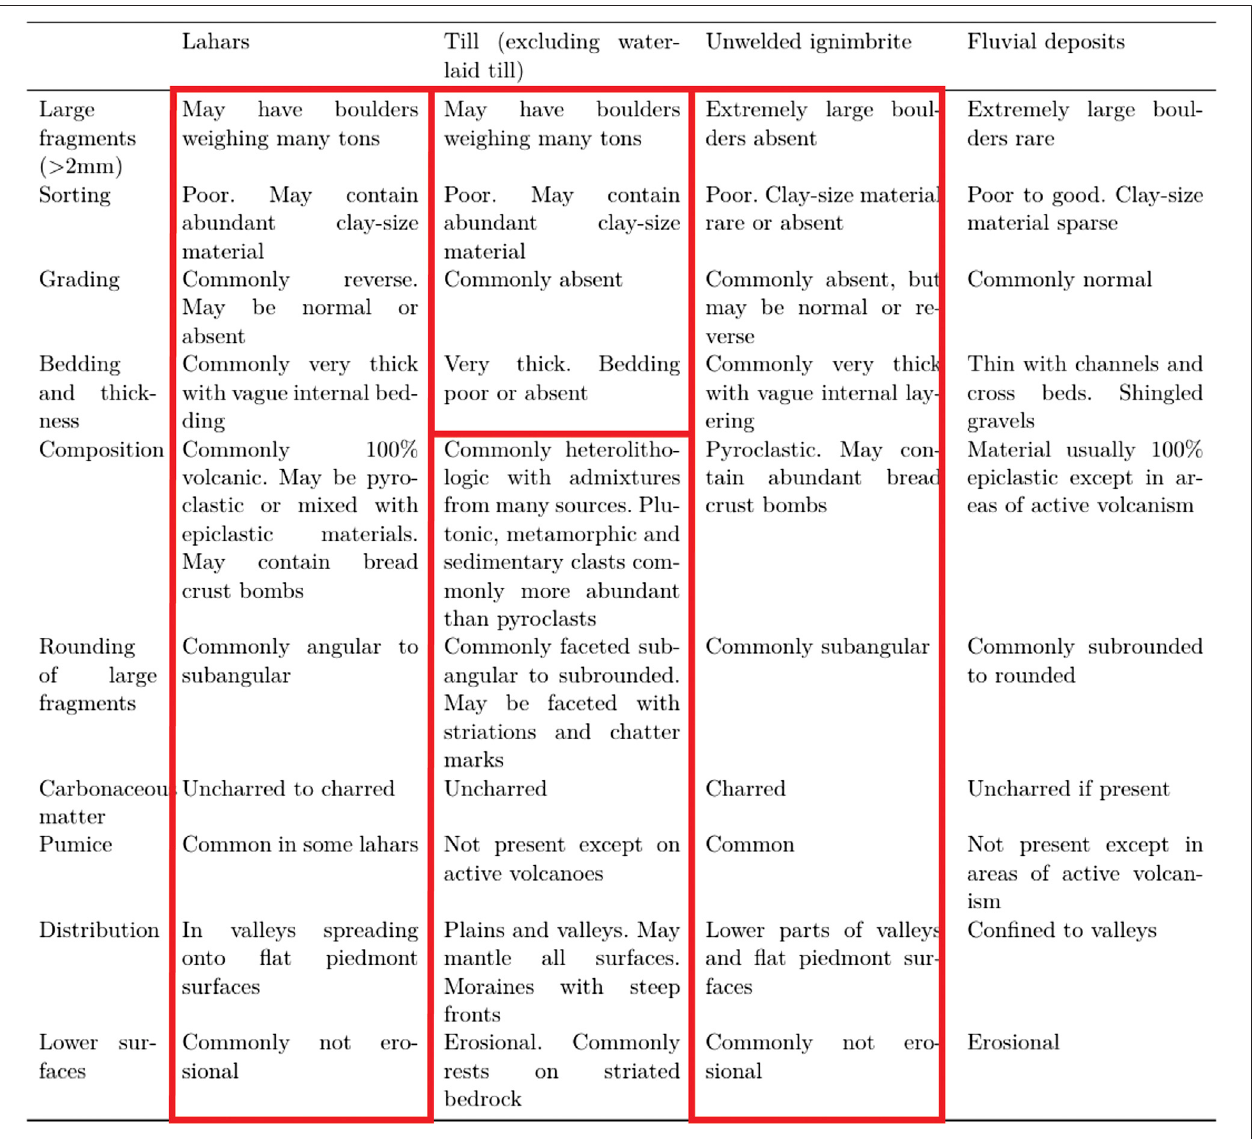
FIGURE 1 | Example of an identi fi cation table for different volcaniclastic deposits adapted from Fisher and Schmincke (1984). The overlain boxes highlight the similarities between the identifying criteria, making it dif fi cult to con fi dently distinguish between the different deposits. Adapted by permission from Springer Nature: Springer, Berlin, Heidelberg, Pyroclastic Rocks by Fisher, R.V. and Schmincke, H.-U., COPYRIGHT 1984.